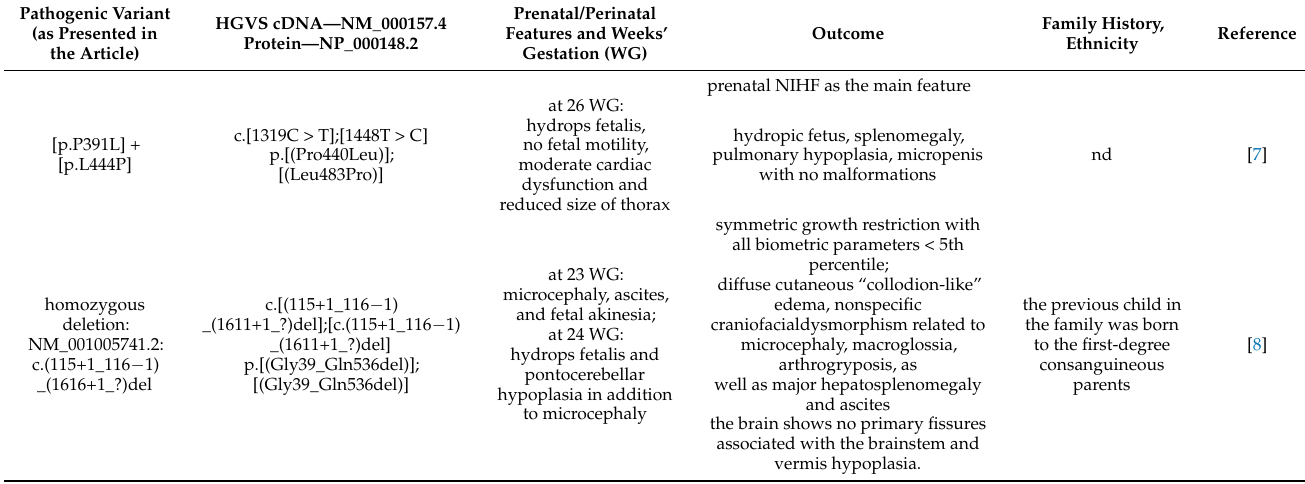
Table 1. GBA variants identified in Gaucher disease based on prenatal or perinatal-lethal complication. Pathogenic Variant (as Presented in the